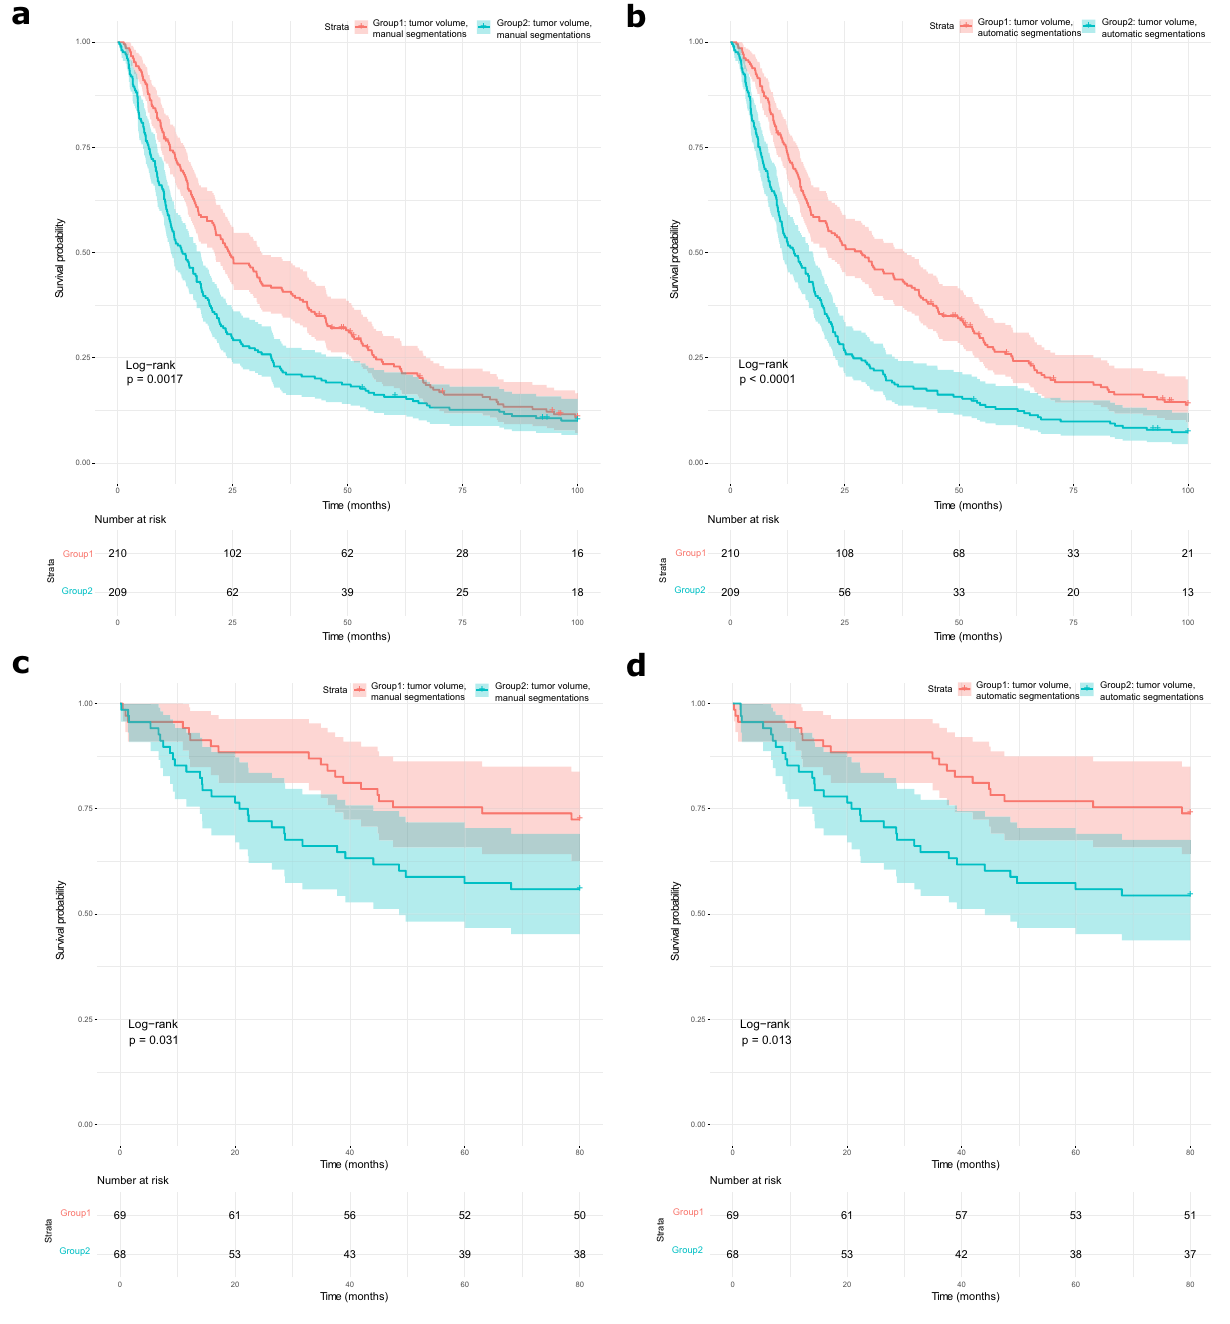
Fig. 4 Prognostic power of NSCLC segmentations measured with tumor volume. Comparison of prognostic power of non-small cell lung cancer (NSCLC) segmentation is measured through tumor volume. Tumor volume is calculated based on the manual ( a , c ) and automatically generated contours ( b , d ). Kaplan – Meyer curves for survival groups based on tumor volume are displayed with 95% pointwise con fi dence intervals. P values are calculated using the log-rank test. Vertical hash marks indicate censored data. a , b KM curves for Maastro-CT-Lung-1 cohort of 419 NSCLC patients. c , d KM curves for Stanford Lung cohort of 137 NSCLC (IQR = 12%) and radiologists and radiation oncologists = 59% (IQR = 13%) (Fig. 13b suppl.).